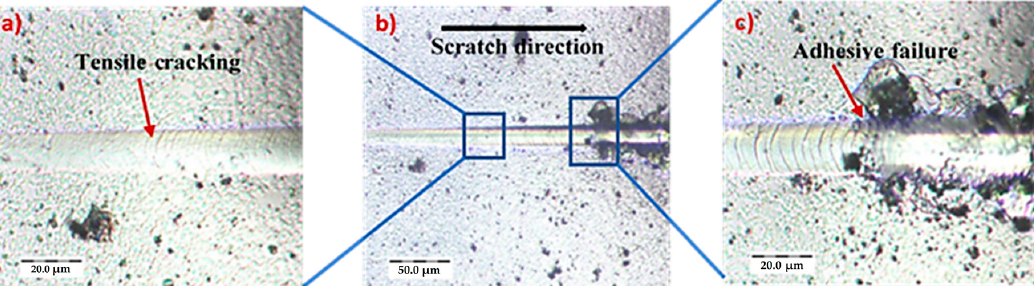
Figure 8. ( a – c ) Microscopic images of the ramped load scratch test track showing the cohesive ( a ) and adhesive ( c ) failure within the studied coating (same failure mechanism for all the studied coatings).